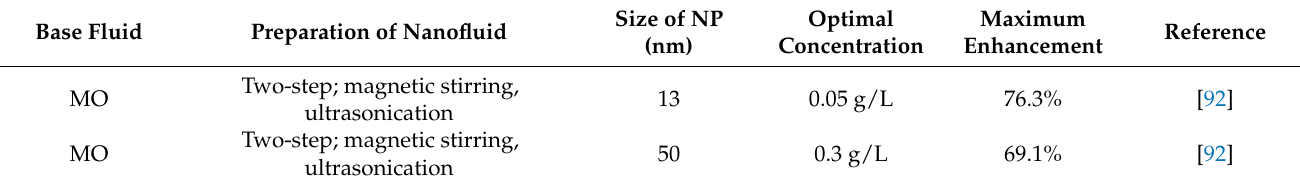
Table 2. Al 2 O 3 AC-BDV overview table. The size of NP refers to the nanoparticle core size, while the optimal concentration indicates the concentration value for which the maximal enhancement of AC-BDV was found. Base